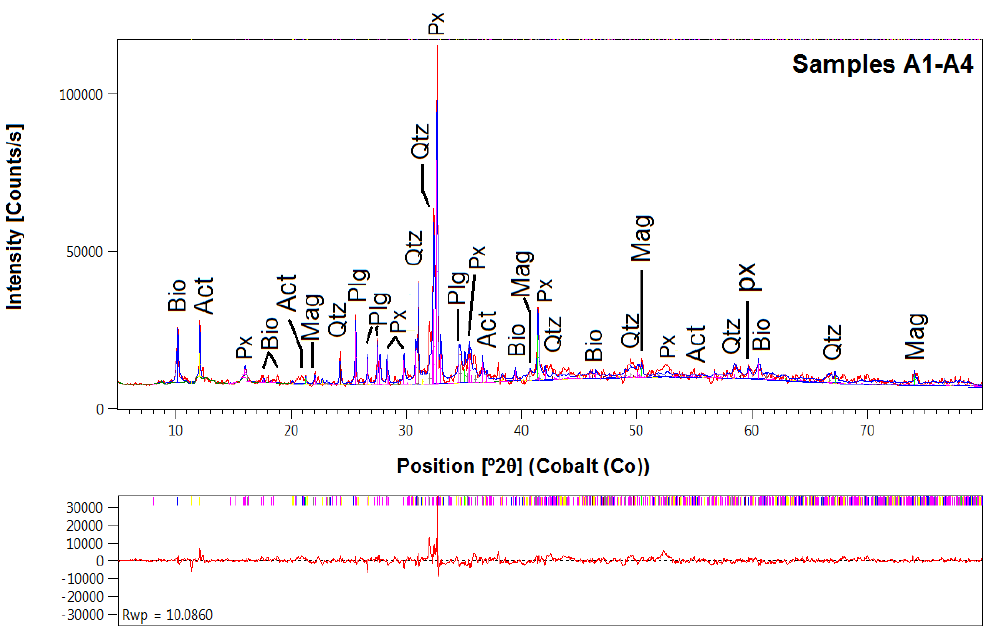
Figure 4. X-ray diffraction pattern of samples A1–A4. Px = pyroxene; Plg = plagioclase; Qtz = quartz; Mag = magnetite; Bio = biotite; Act = actinolite. Observed spectra (red line), fitted spectra (blue solid line), difference plot (below spectra), and Bragg peak positions (tick marks above difference plot) are shown. The weighted R-factor, Rwp, was calculated using the observed and calculated intensities in the powder diffraction patterns.